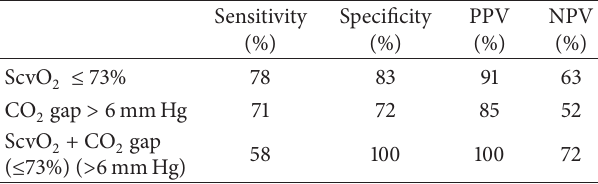
ScvO 2 : central venous oxygen saturation; CO 2 gap: venous-to-arterial car- bon dioxide difference; PPV: positive redictive value; NPV: negative predic- tive